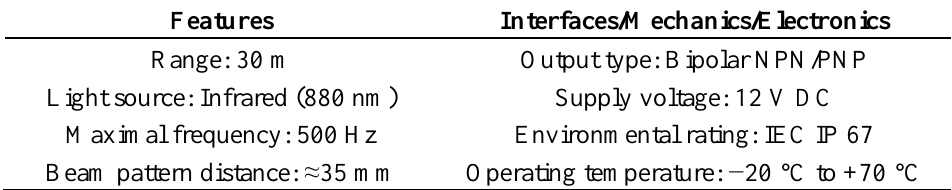
Table 2. Mini-Beam SM31 EL/RL technical